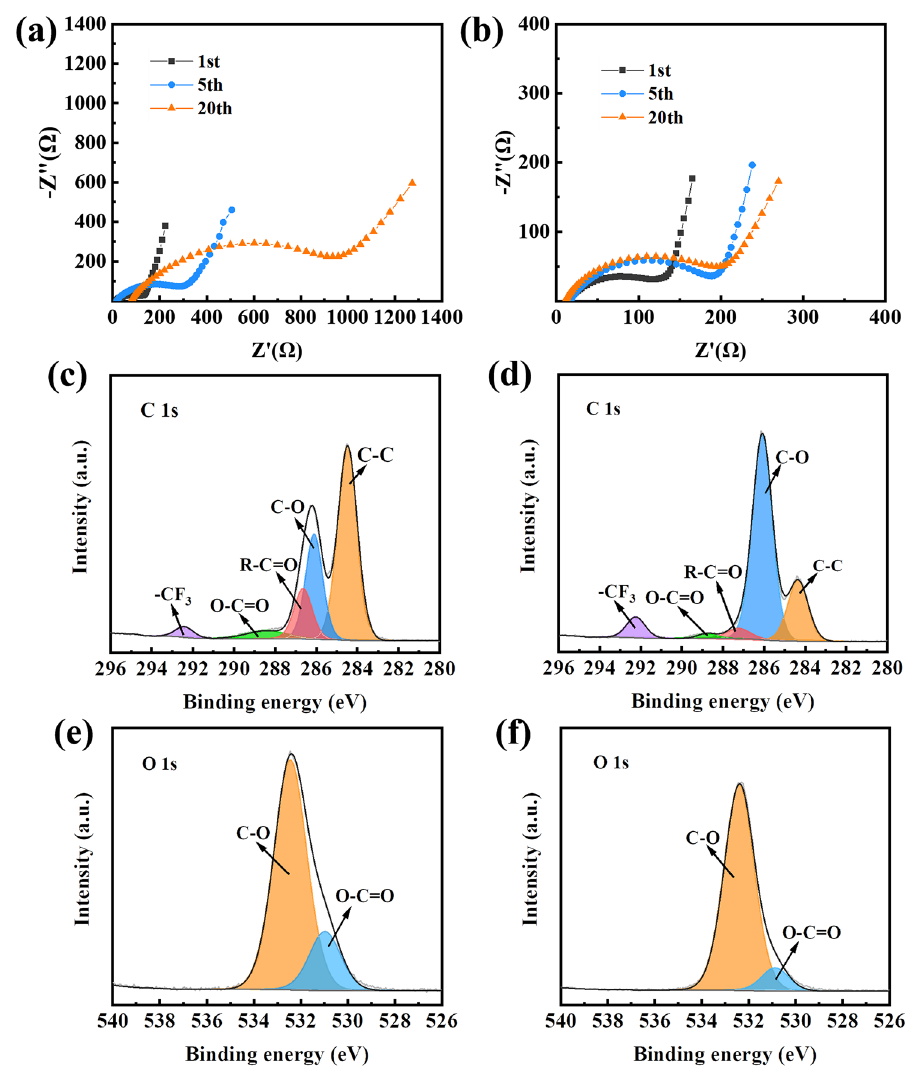
Fig. 5 EIS spectra of a LCO/PEO-LiTFSI/Li cell and b LAF@LCO/PEO-LiTFSI/Li cell after cycling in voltage range of 3.0–4.5 V. C 1 s from PEO-based SPE surface after cycling with c LCO electrode and d LAF@LCO electrode. O 1 s from PEO-based SPE surface after cycling with e LCO electrode and f LAF@LCO electrode. Cycled samples were obtained from the ASSLBs after 30 cycles in voltage range of 3.0–4.5